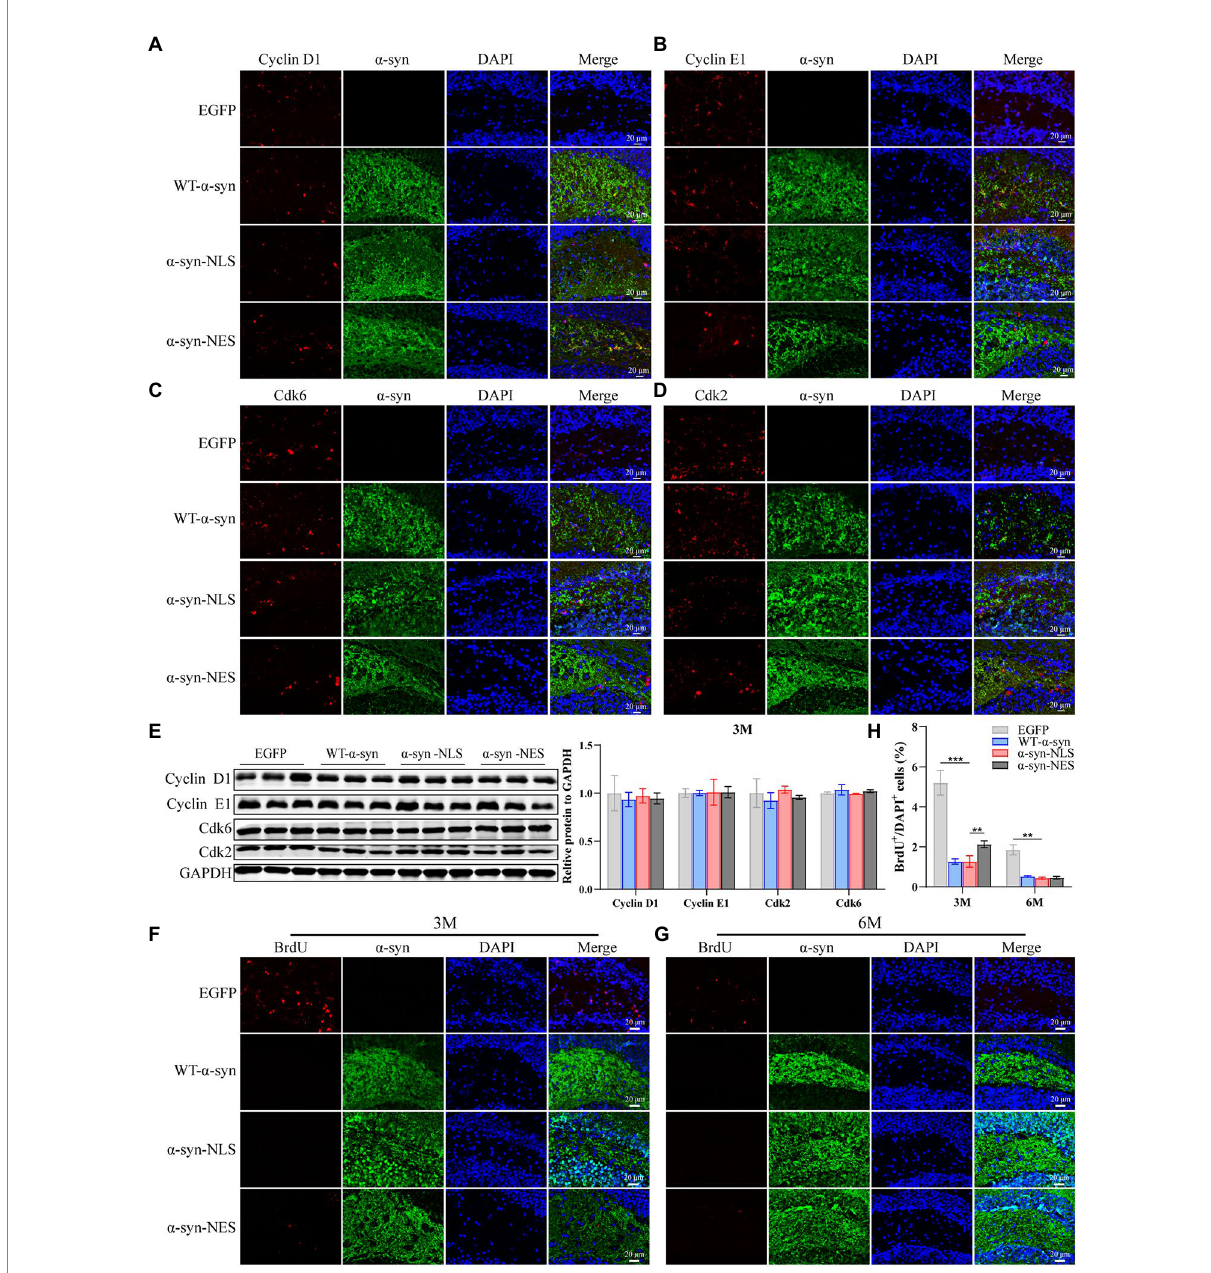
FIGURE 7 Long-term overexpression of α -syn inhibits neural cell proliferation. (A–D) The expression of cell cycle S phase proteins CDK2, CDK6, Cyclin D1, and Cyclin E1 was detected by immunofluorescence at month 3 after virus injection. (E) Western blot with CDK2, CDK6, Cyclin D1, and Cyclin E1 antibodies at month 3 after virus injection and their relative levels ( n = 3). (F) Representative BrdU-positive cells staining image at month 3 after virus injection. (G) Representative BrdU-positive cells staining image at month 6 after virus injection. (H) BrdU + cells were quantified at months 3 and 6 after virus injection ( n = 4). ** p < 0.01, *** p <